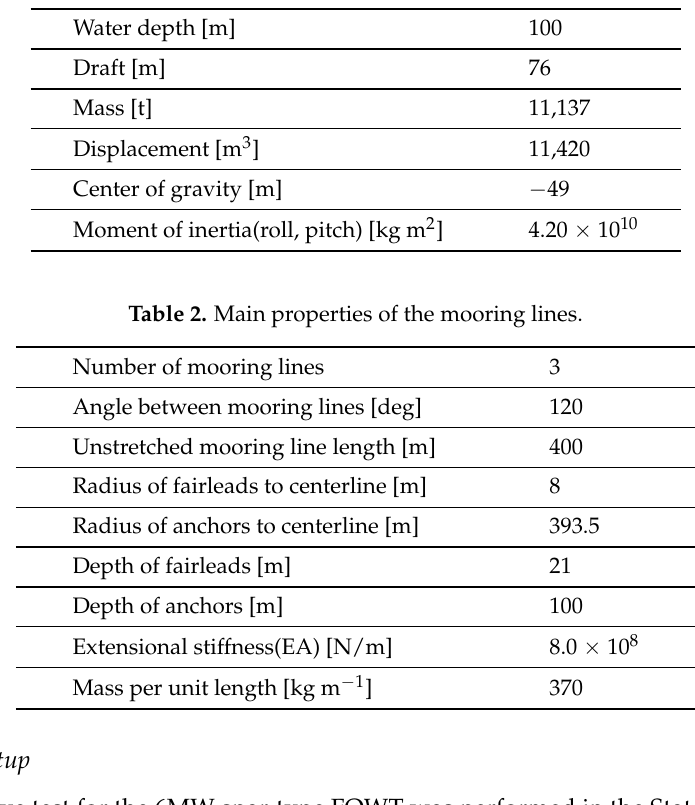
Table 1. Main parameters of the spar platform of a 6MW spar-type FOWT in full scale.